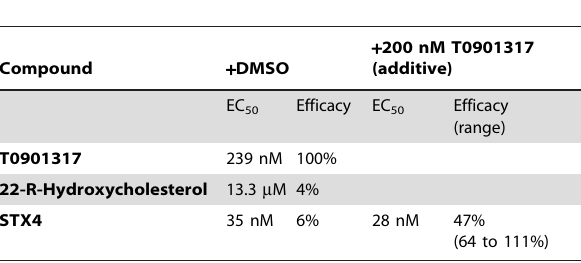
Table 1. Results from competitive reporter-gene